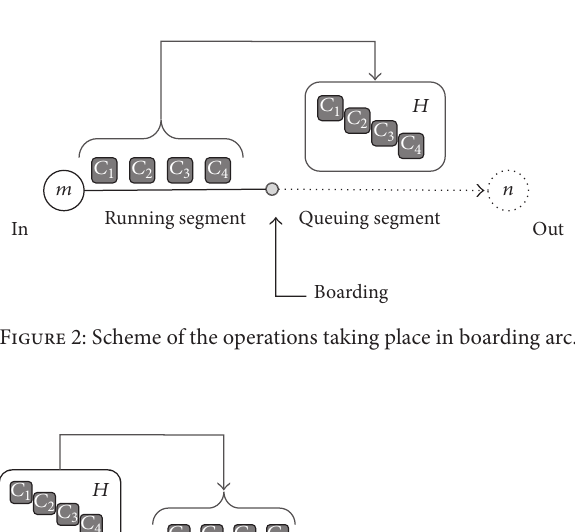
units) and, as reverse operation, the alighting of the guest points from tank